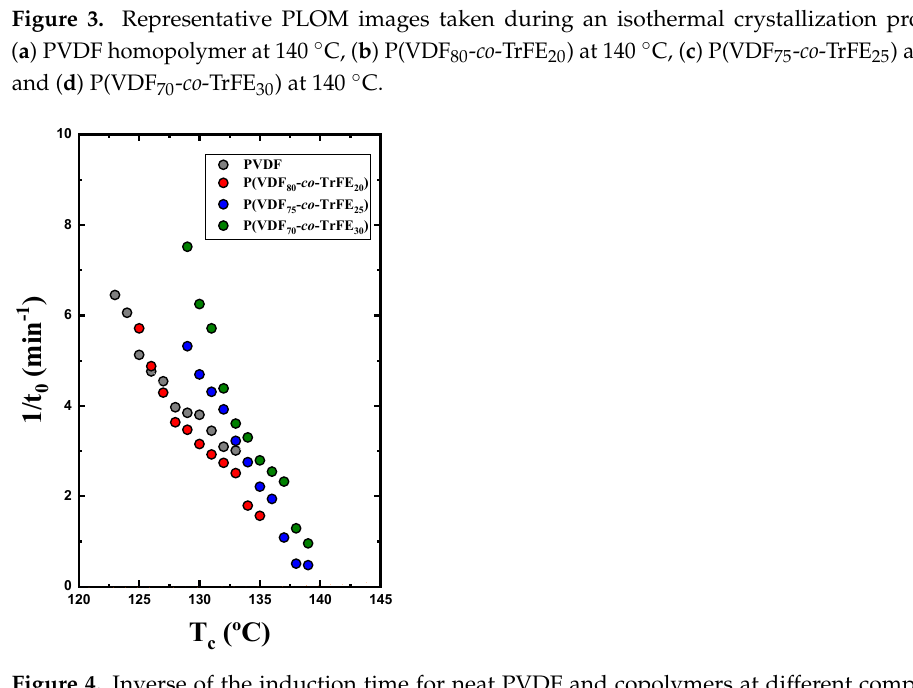
Figure 4. Inverse of the induction time for neat PVDF and copolymers at different compositions against the isothermal crystallization temperature.